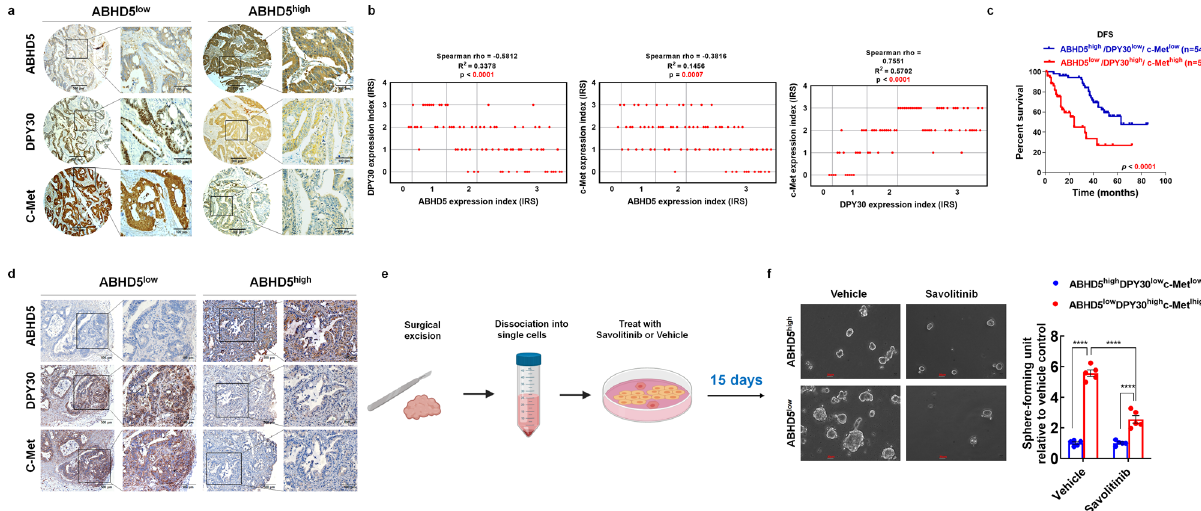
Fig. 7 ABHD5 low /DPY30 high /c-Met high CRCs show worse prognosis compared with ABHD5 high /DPY30 low /c-Met low CRCs but may bene fi t from Met inhibitor. a Represent immunohistochemistry stainings of ABHD5/DPY30/c-Met in CRC tissue microarray. Score = 0 – 1 (low) and score = 2 – 3 (high) indicate ABHD5, DPY30, and c-Met levels in representative tumour tissues. Scale bars, 500 μ m (main micrographs) and 100 μ m (insets). b Correlation analyses for the correlation between ABHD5, DPY30 and c-Met in CRC tissues. Plotted data are the expression index calculated from immunostaining. Spearman correlation analysis ( n = 76 biologically independent samples). c Disease-free survival (DFS) of CRC patients with ABHD5 low /DPY30 high / c-Met high ( n = 53) or ABHD5 high /DPY30 low / c-Met low CRC tumours ( n = 54 biologically independent samples). d Represent immunohistochemistry stainings of ABHD5/DPY30/c-Met in surgically resected CRC tissues. Scale bars, 500 μ m (main micrographs) and 100 μ m (insets). e Schematic of the experiment. Surgically resected ABHD5 high /DPY30 low /c-Met low or ABHD5 low /DPY30 high /c-Met high CRC tumours were dissociated into single cells. Ex vivo sphere formation assays of tumour-derived cells were performed in the presence of 1 μ M savolitinib or DMSO (vehicle). f Representative images and statistical analyses of cancer cell spheres derived from surgically resected ABHD5 high /DPY30 low /c-Met low or ABHD5 low /DPY30 high /c-Met high CRC tumours ( n = 5 biologically independent samples) (Data are shown as mean ± s.e.m. The correlation analysis was determined by Spearman correlation coef fi cient in panel ( b ). Kaplan − Meier survival method was used in panel ( c ). Panel ( f ) was analysed using two-way ANOVA and Sidak ’ s